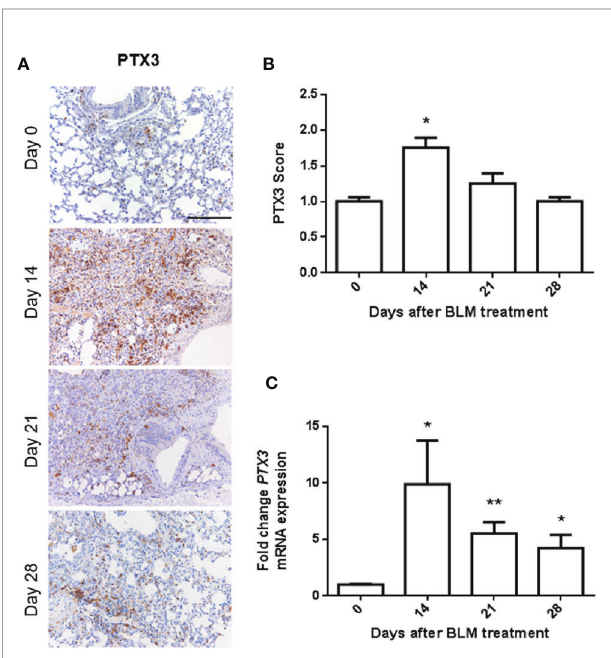
FIGURE 1 | PTX3 expression is induced in BLM-induced lung fi brosis. PTX3 expression in the lungs of C57BL/6 wild type mice treated with bleomycin (BLM) and sacri fi ced at day 0, 14, 21, and 28 after treatment was detected by immunohistochemistry (A) and quanti fi ed by scoring the immunostaining (B) or by qPCR (C) . N = 5 – 8 mice/group; scale bar = 200 µm; *P < 0.05, **p <